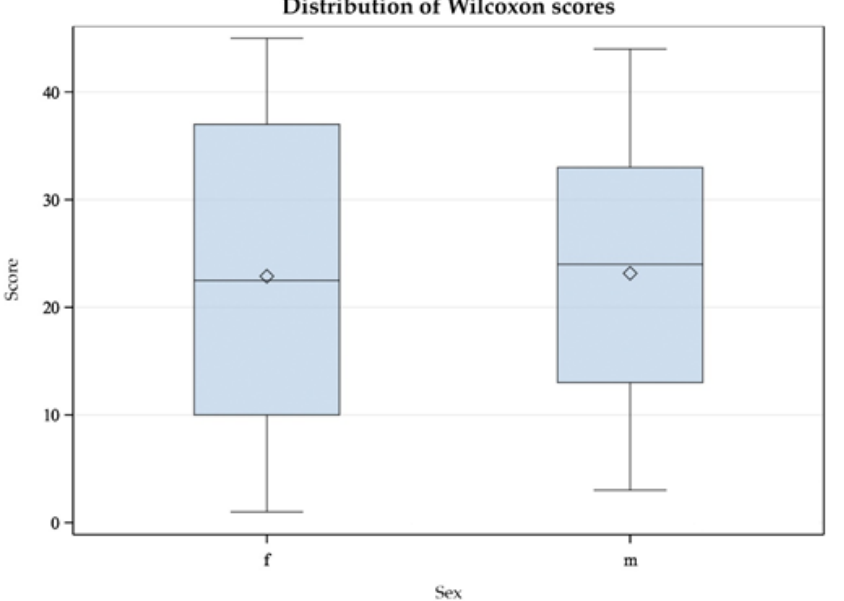
Figure 4. Bland-Altman plot of Greater Flamingos ( Phoenicopterus roseus ); the residual plot displays the differences ( y -axis) against the means of values ( x -axis) of CORTf in the two sampling methods. The blue horizontal lines represent the mean difference ± 2 SD (mean = − 0.13, SD = 0.76). In similar studies with Common Redpolls ( Acanthis flammea ) and Snow Petrels ( Pago- droma nivea ), a difference in plasma CORT level between the sexes was found [37,40]. Therefore, we investigated the relationship between sex and CORTf level using the Mann- Whitney U Test. This test was applied because the data were not normally distributed [56]. Results are displayed in a box-plot figure (see Figures 5 and 6).